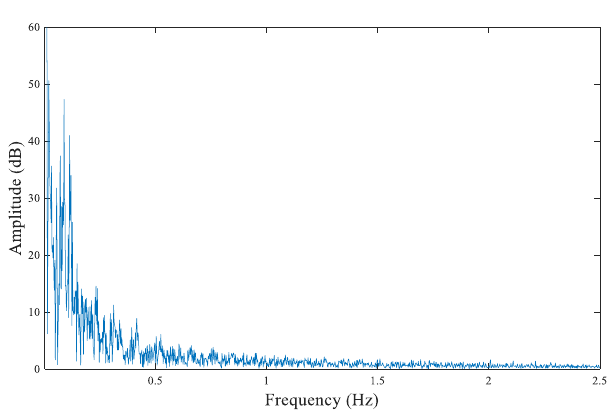
Figure 13. The signal frequency spectrum (0–2.5 Hz).